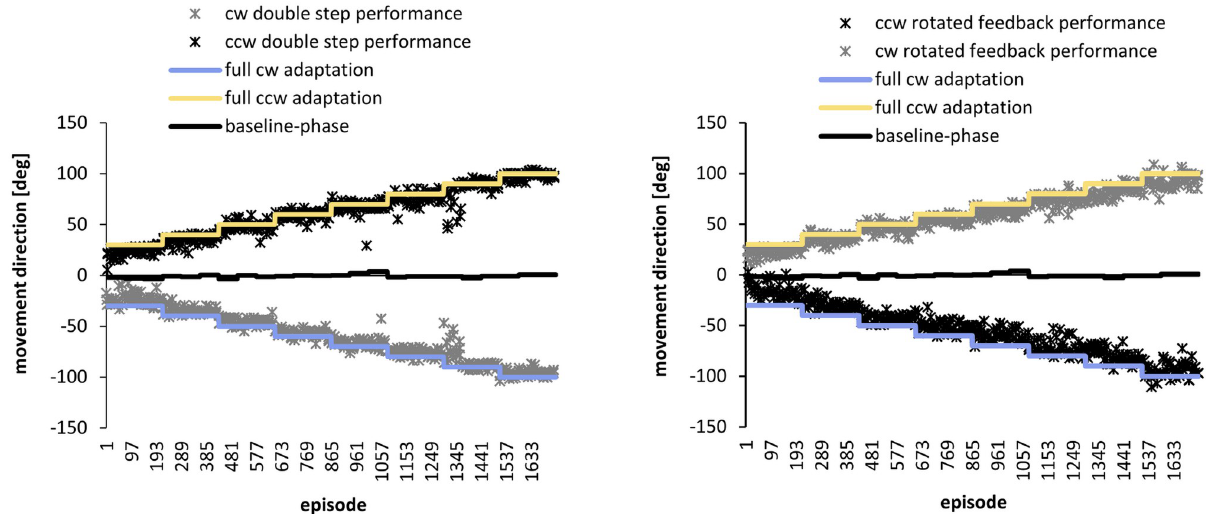
Fig 3. Performance of one participant. The participant adapted to clockwise (cw) double steps in the distal workspace, counterclockwise (ccw) double steps in the proximal workspace, counterclockwise rotated feedback in the distal workspace, and clockwise rotated feedback in the proximal workspace. Illustrated are the movement directions measured 100 ms after movement onset. Each dot represents the mean of one episode, i.e., of 5 movements. All episode means of the intervention are shown. The solid blue and orange lines represent the expected values for complete adaptation of movement directions to the angular transformations 30˚-100˚. The solid black line near the Abscissa represents the performance during the baseline phase.